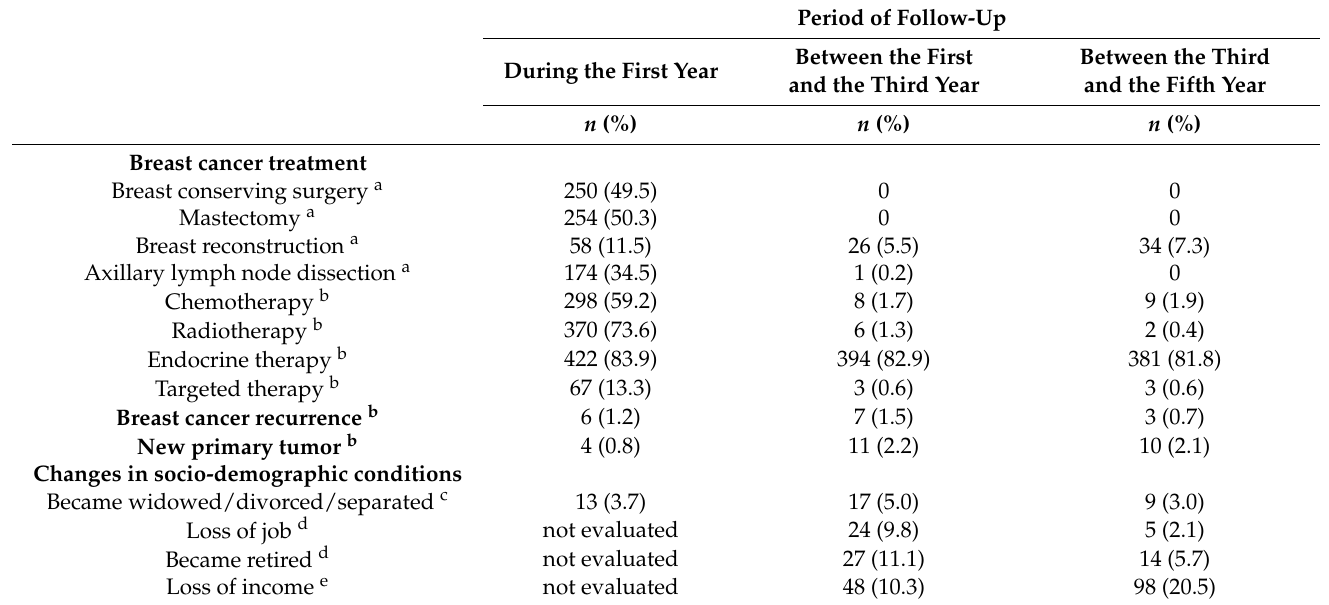
Table 2. Breast cancer treatments and changes in clinical and socio-demographic characteristics of the participants, over the five-year follow-up. Period of Follow-Up Between the First Between the Third During the First Year and the Third Year and the Fifth Year n